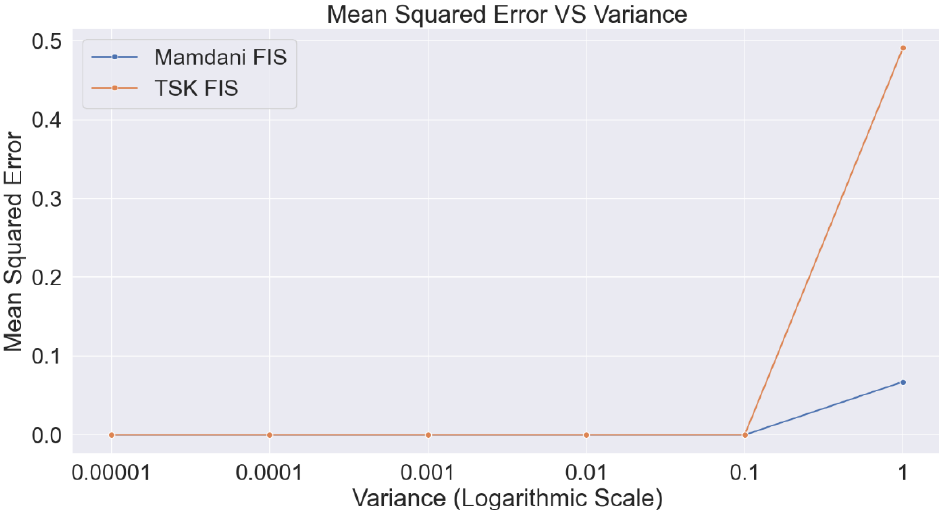
Figure 11. Mamdani vs. TSK noise benchmark.